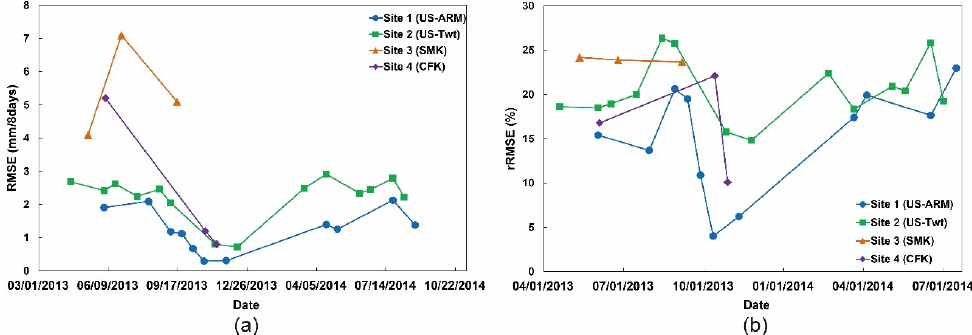
Figure 6. RMSE and rRMSE (%) of Landsat-aggregated 1 km ET against MODIS ET: ( a ) RMSE and ( b ) rRMSE (%) for Sites 1, 2, 3, and 4.